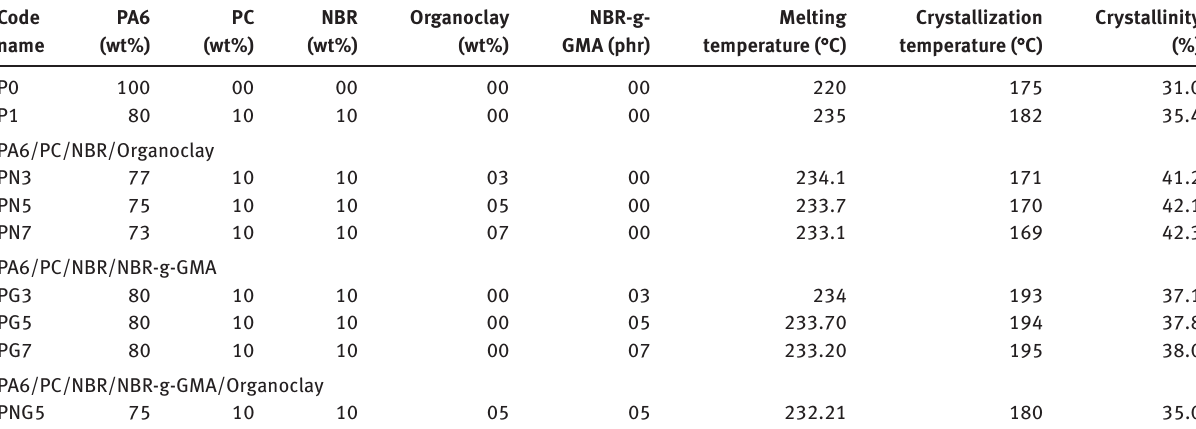
Table 1: Sample designations and results of differential scanning calorimetry in non-isothermal conditions.